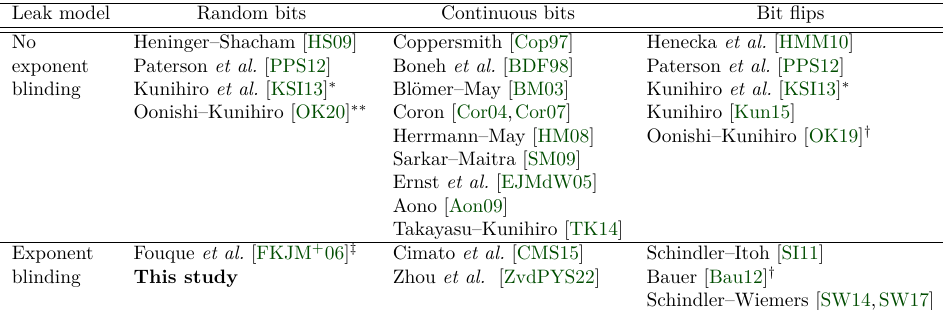
Table 2: Major partial key exposure attacks on